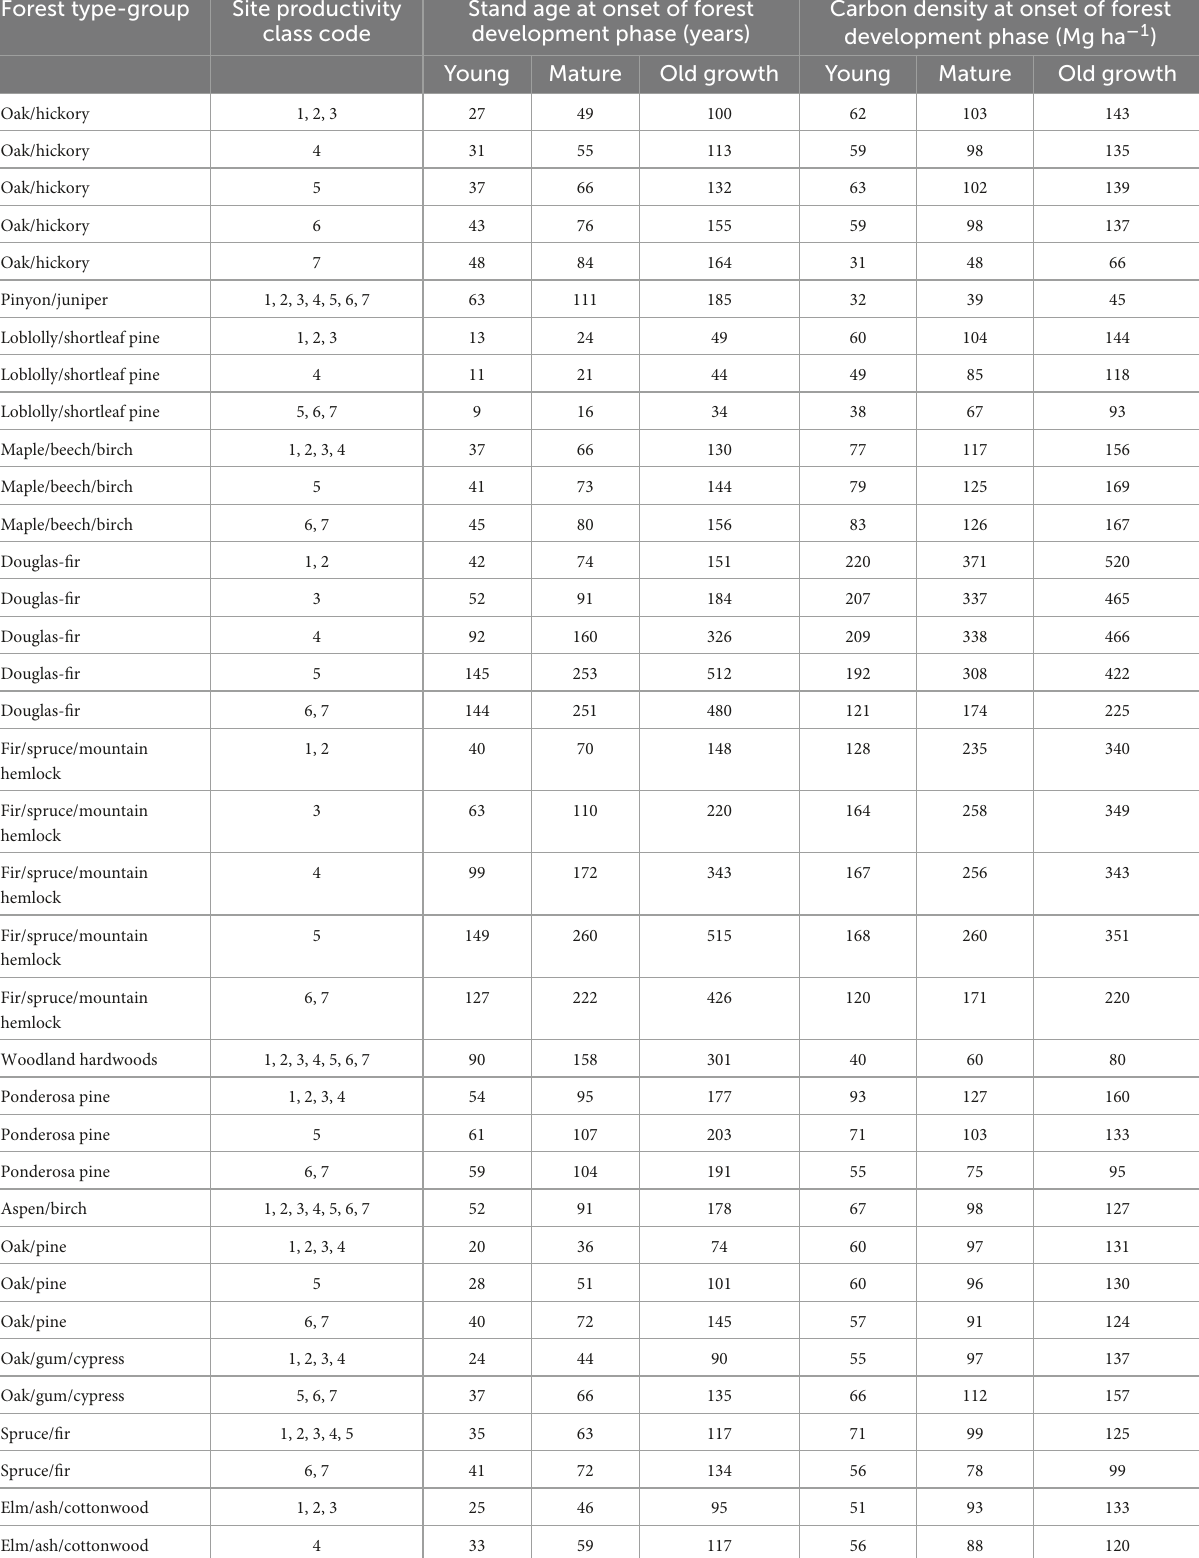
TABLE 2 Age and forest carbon density associated with the estimated age at transitions between stand development phases. Forest